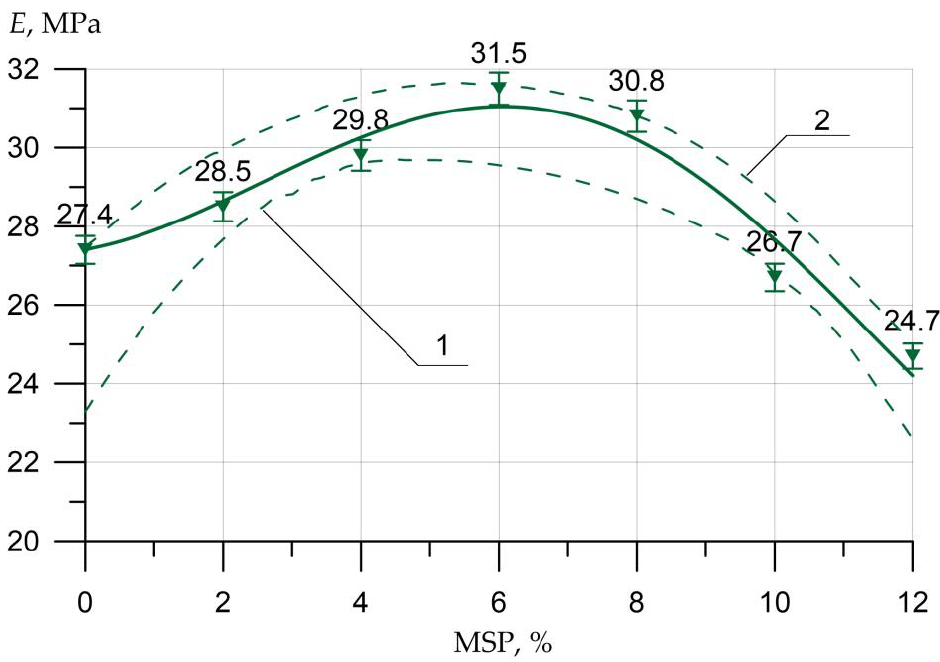
Figure 10. Effect of MSP dosage on ultimate strains in axial tension (USAT) ε bt : 1—lower confidence level; 2—upper confidence level.